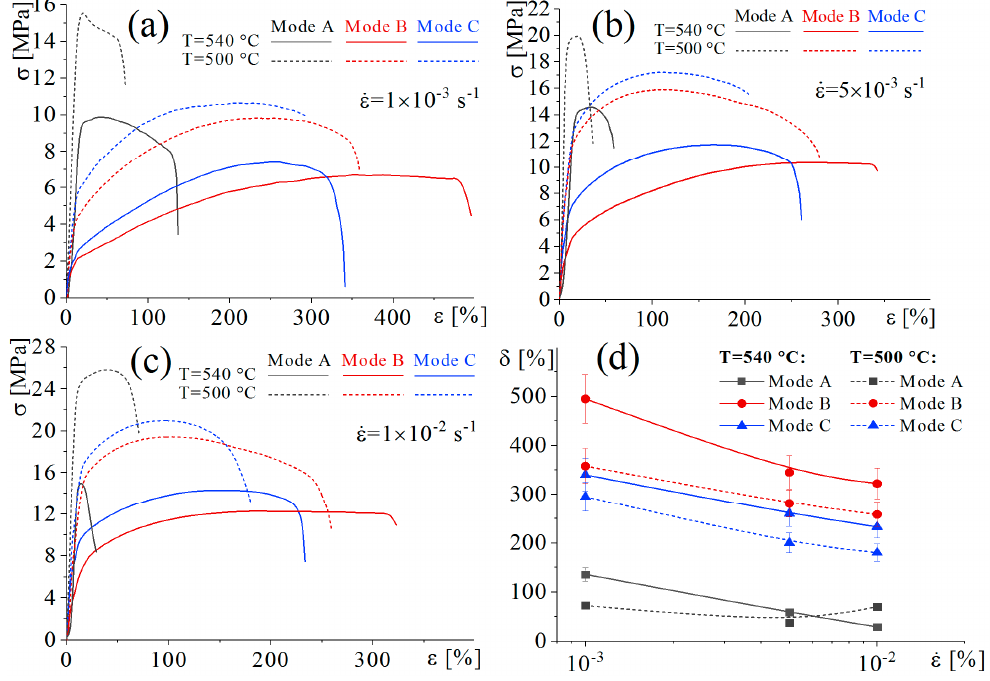
Figure 8. The flow stress–strain curves at constant strain rates of 1 × 10 − 3 s − 1 ( a ), 5 × 10 − 3 s − 1 ( b ) and 1 × 10 − 2 s − 1 ( c ) and ( d ) elongation to failure at temperatures of 500 °C and 540 °C.